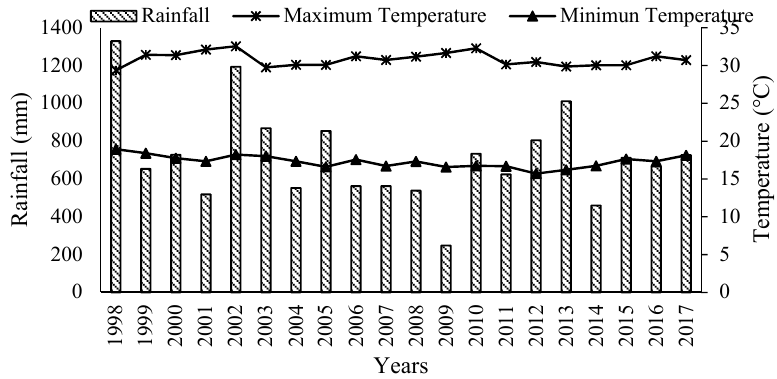
Figure 1. Average yearly temperature (minimum and maximum) and total annual rainfall during the study period.